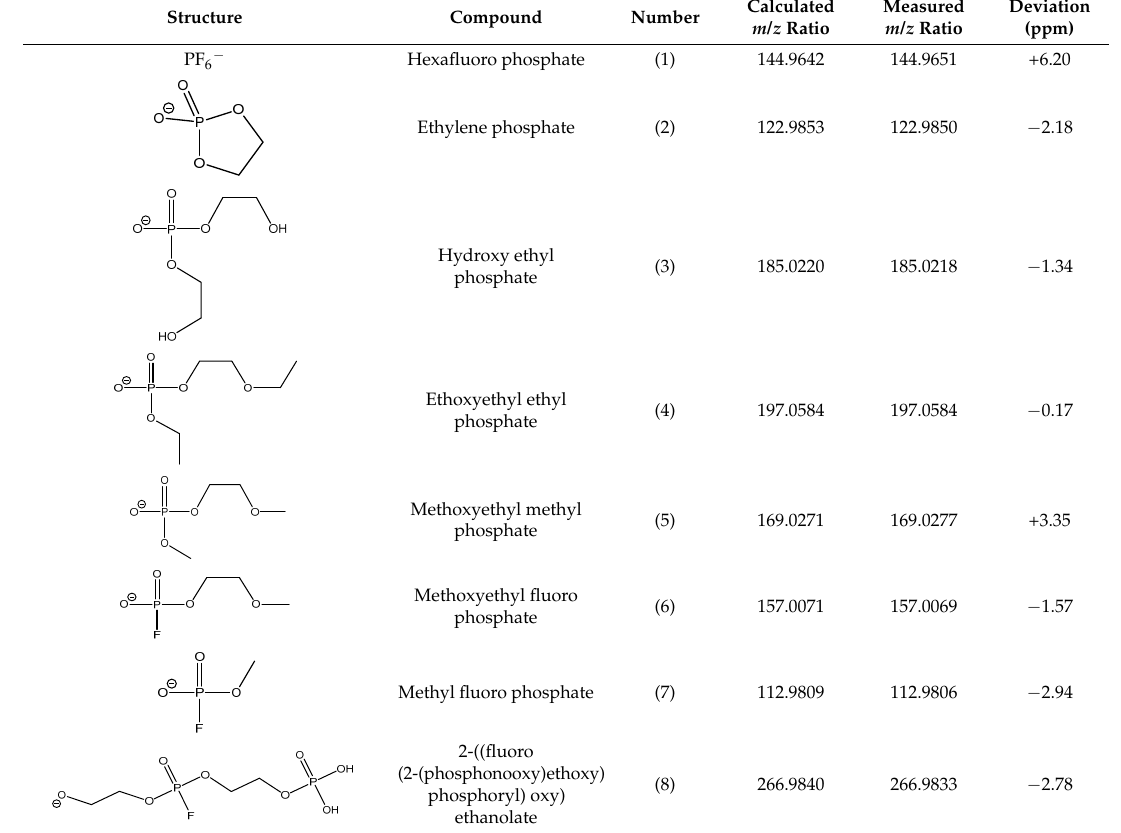
Figure 4. Electropherogram of the aged reference electrolyte sample. Table 1. Proposed structures for the calculated and measured m/z ratios together with the deviation in ppm in the aged electrolyte samples.